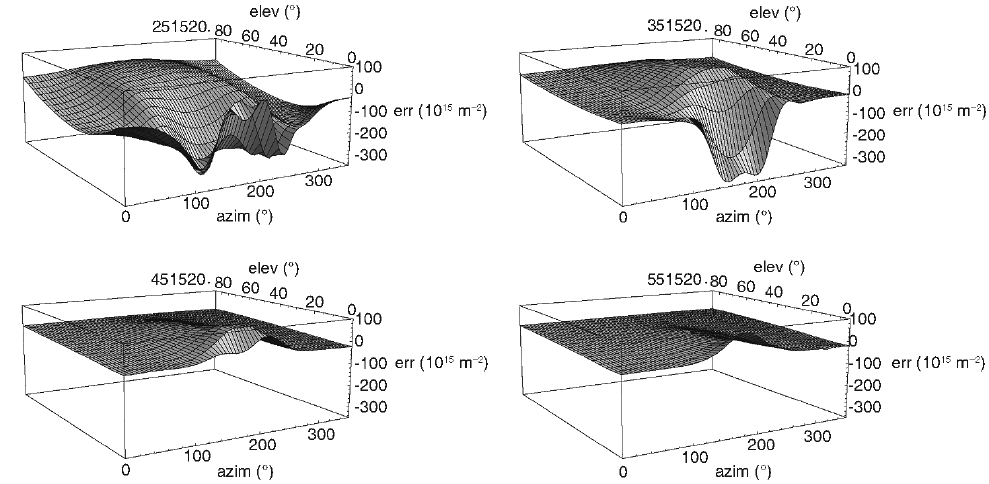
Fig. 18.1. Ground station approach: error dependence on satellite elevation and azimuth. Ground station lati- tude 25°N, 35°N, 45°N, 55°N respectively, for 15°E and 20:00